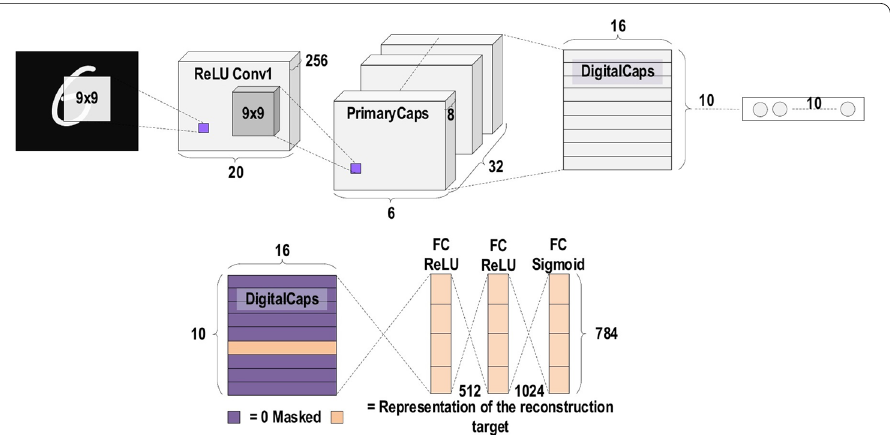
Fig. 25 The complete CapsNet encoding and decoding